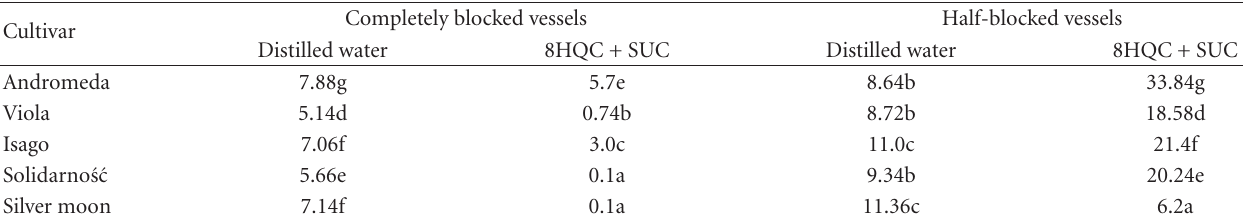
Table 3: Average number of blocked vessels (in percent) in Clematis stems stored in distilled water and 8HQC with 2% sucrose, term I. Completely blocked vessels Half-blocked vessels Cultivar Distilled water 8HQC + SUC Andromeda Viola